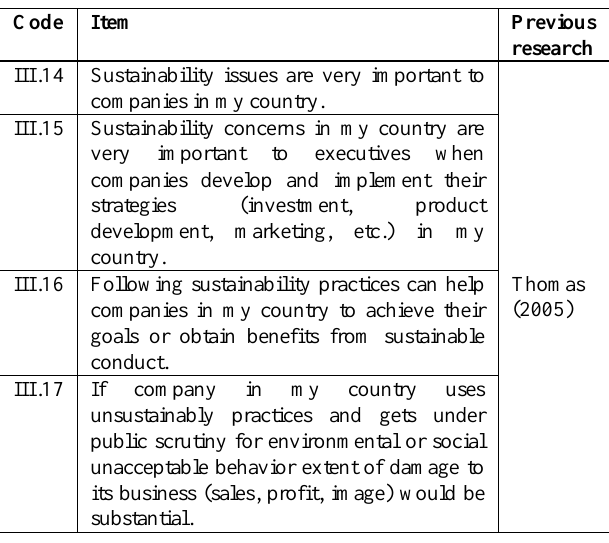
Table 3: Sustainability from business perspective Code